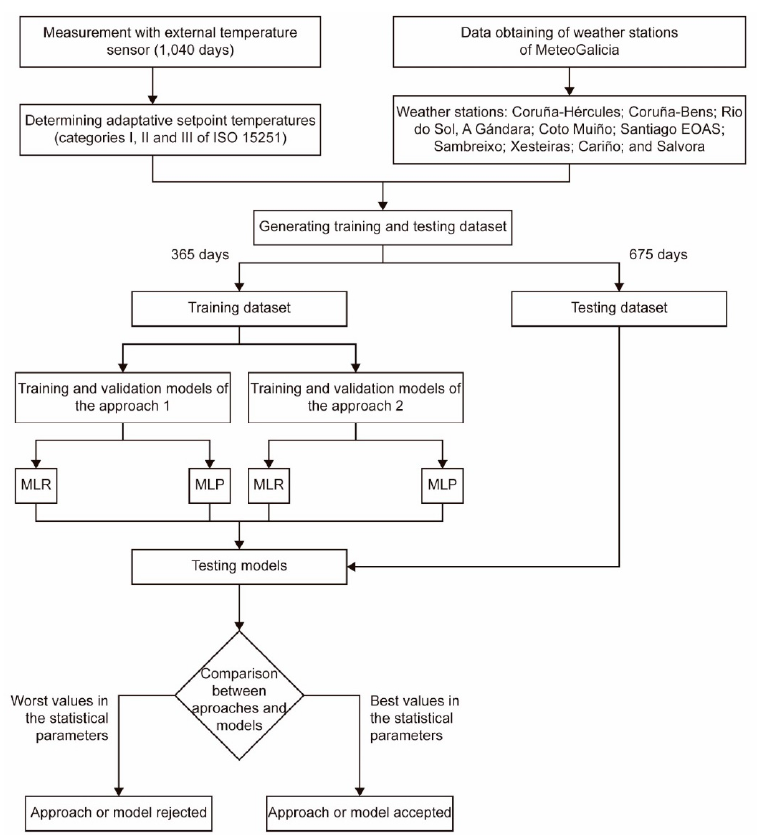
Figure 5. Flowchart of this research.